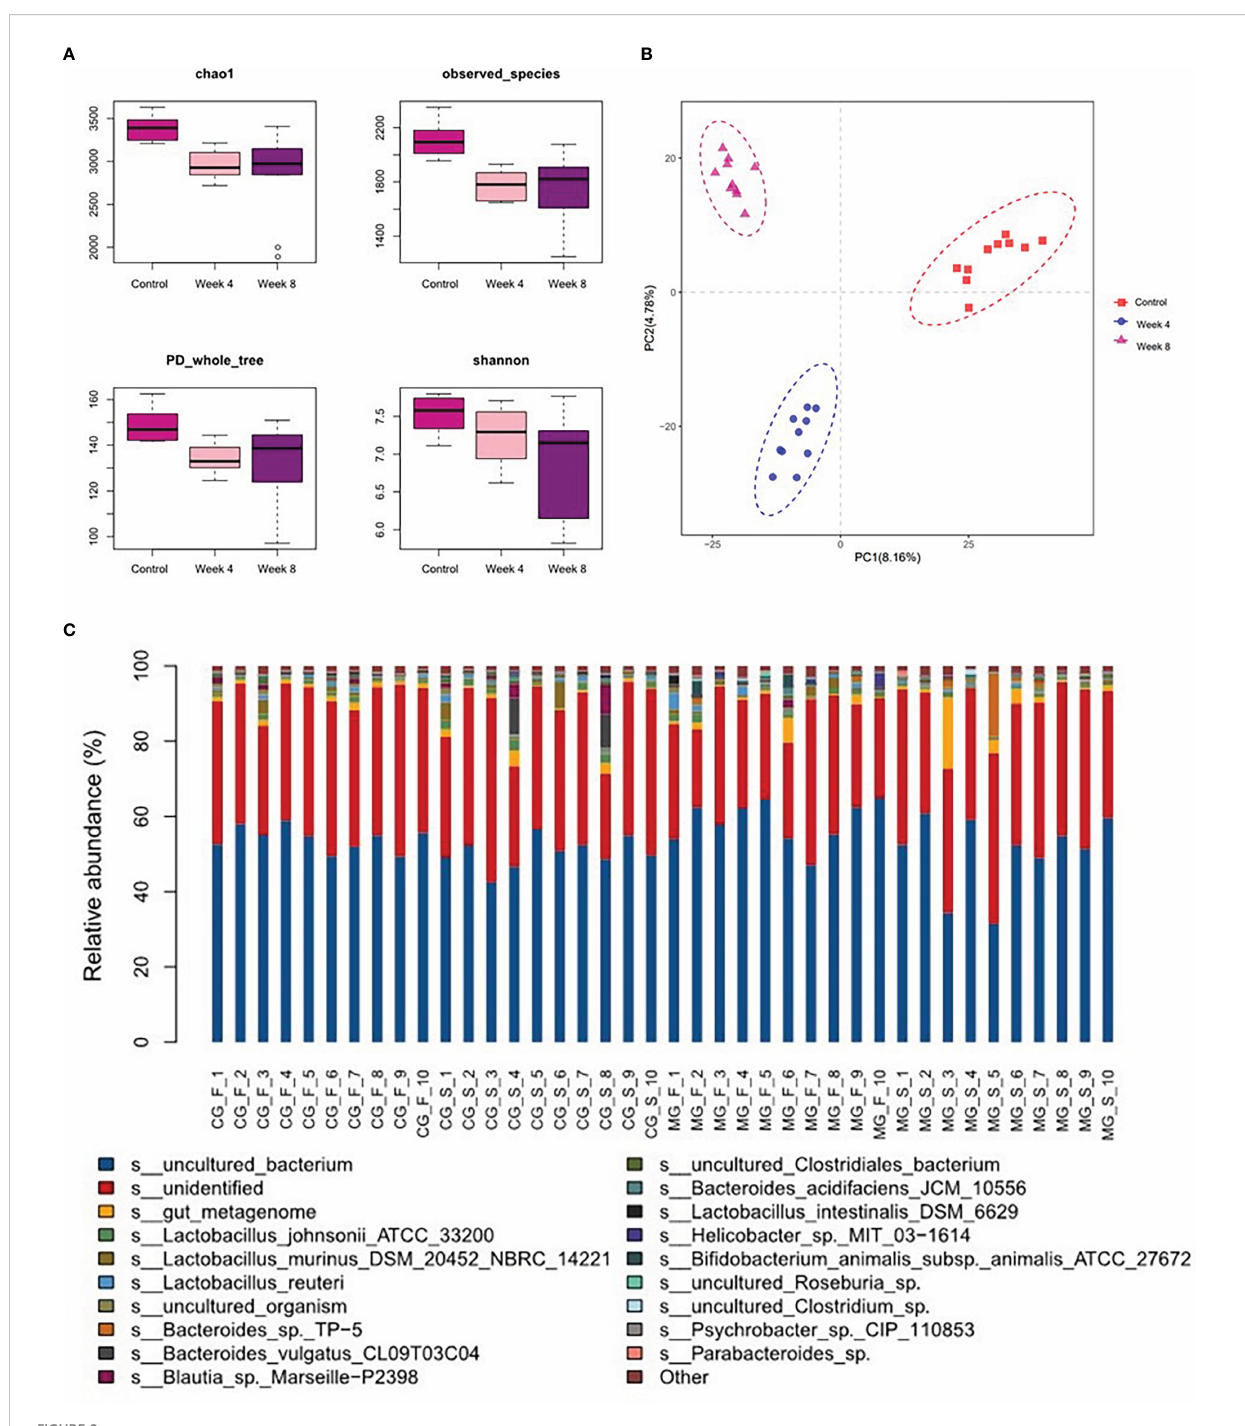
FIGURE 2 Characteristics of the gut microbiota in the depression rat model. (A) a -phylogenetic diversity analysis showing that CUMS rats were characterized by lower microbial richness relative to controls. (B) Orthogonal partial least squares discrimination analysis (OPLS-DA) showed that the gut microbial composition of CUMS rats was signi fi cantly different from that of the control group. (C) Relative abundance of gut microbes at the species level across samples (CG- normal control group; MG-CUMS